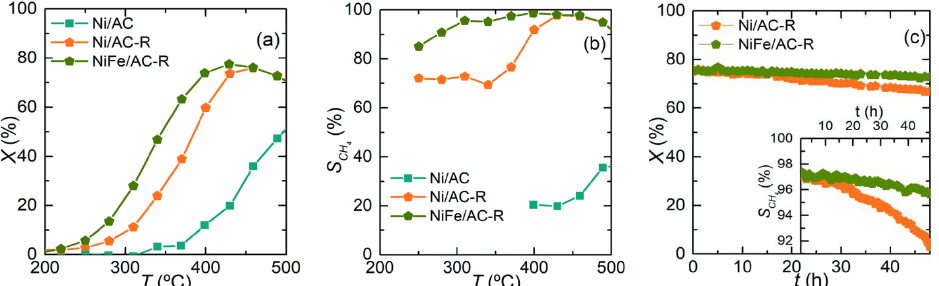
Figure 6. Comparison of the catalytic properties of the best Ni catalyst Ni/AC–R and the same promoted by Fe NiFe/AC–R: X CO2 and S CH4 as a function of temperature ( a , b ) as well as time-on-stream (TOS) at 450 °C ( c ). Reaction conditions: P = 1 bar; Weight Hourly Space Velocity (WHSV) = 60,000 mL g –1 h –1 ; CO 2 :H 2 = 1:4. Reproduced with permission from